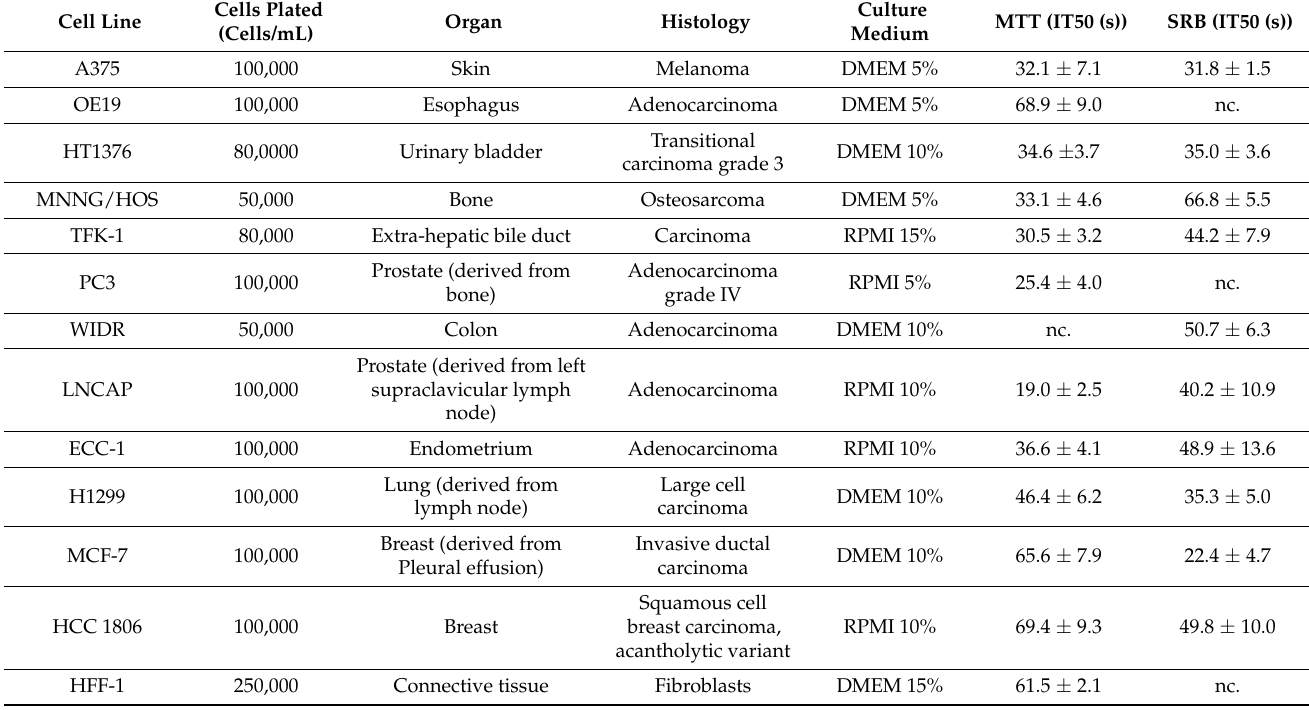
Table 3. Comparison of different characteristics of treated cell lines and the effect of treatment observed. Dose–response curves were traced for each cell line and the treatment duration that was required to reduce metabolic activity and protein content by 50% (IT50) was calculated using MTT and SRB assays, respectively, with software Origin Pro 8.0, with a confidence interval of